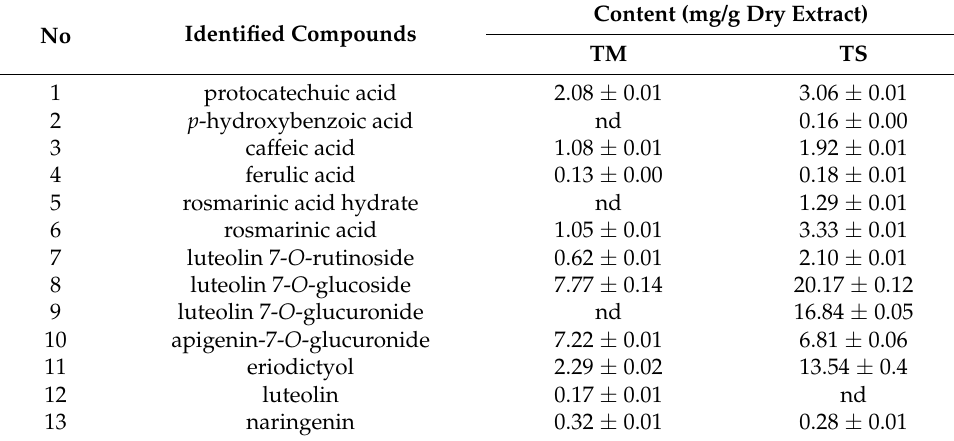
Table 2. The content of polyphenols in the hydroethanolic extracts from the aerial parts of Thymus marschallianus (TM) and Thymus seravschanicus